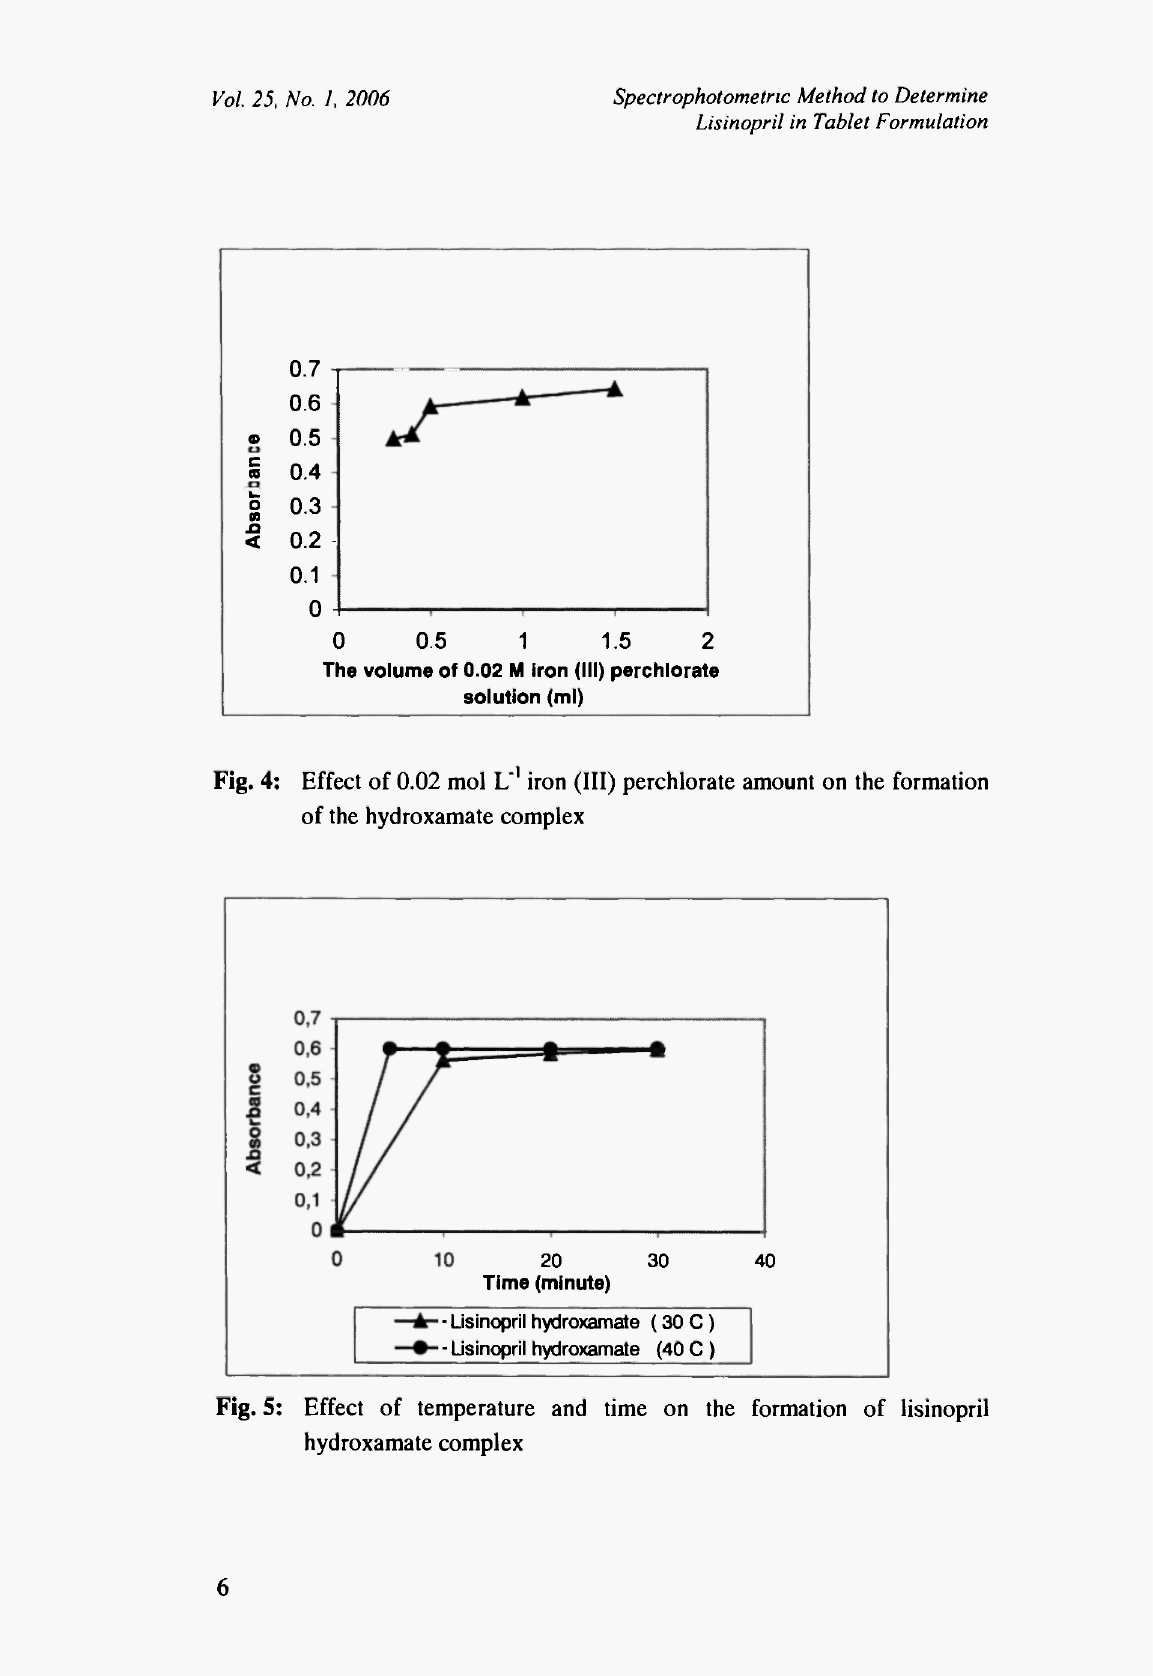
Fig. 5: Effect of temperature and time on the formation of